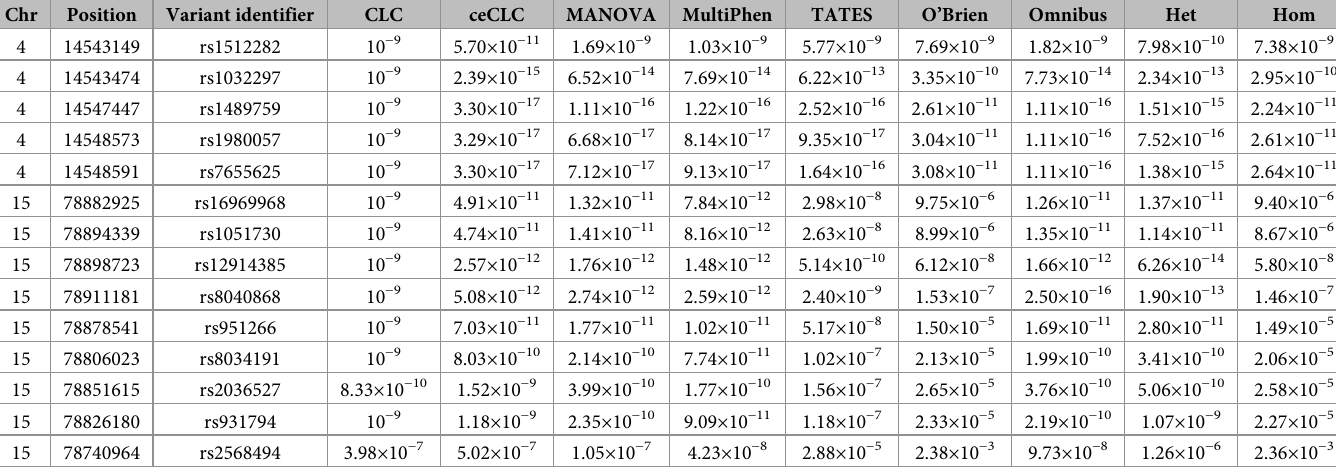
Table 3. Significant SNPs and the corresponding p-values in the analysis of COPDGene